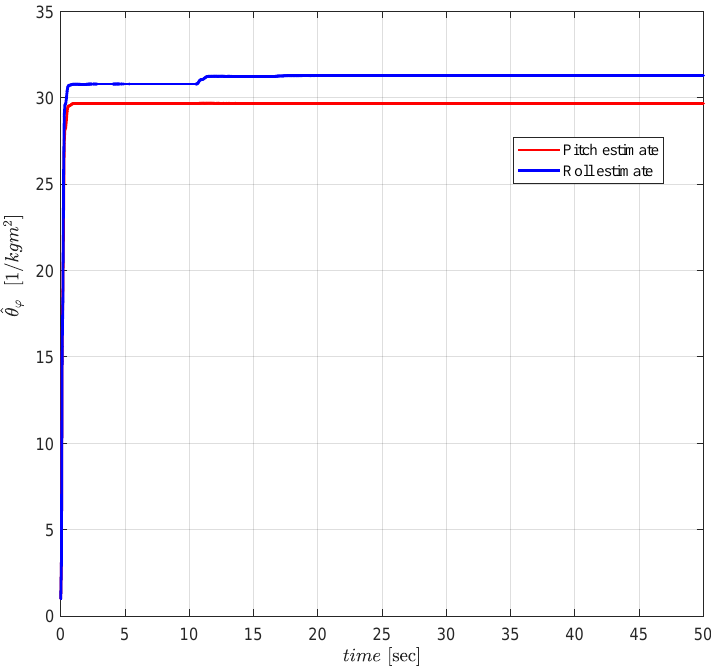
Figure 17. LS based estimate ˆ θ ϕ of the uncertain inertia parameter θ ∗ ϕ for the